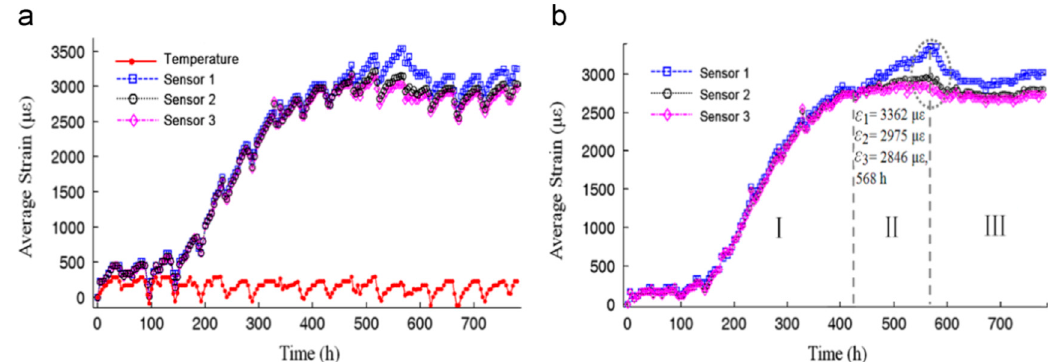
Figure 17. The results from the sensor in R–C–O–C configuration. ( a ) The uncompensated results without the reference fiber; ( b ) The results after being compensated by the reference sensing fiber. [56].